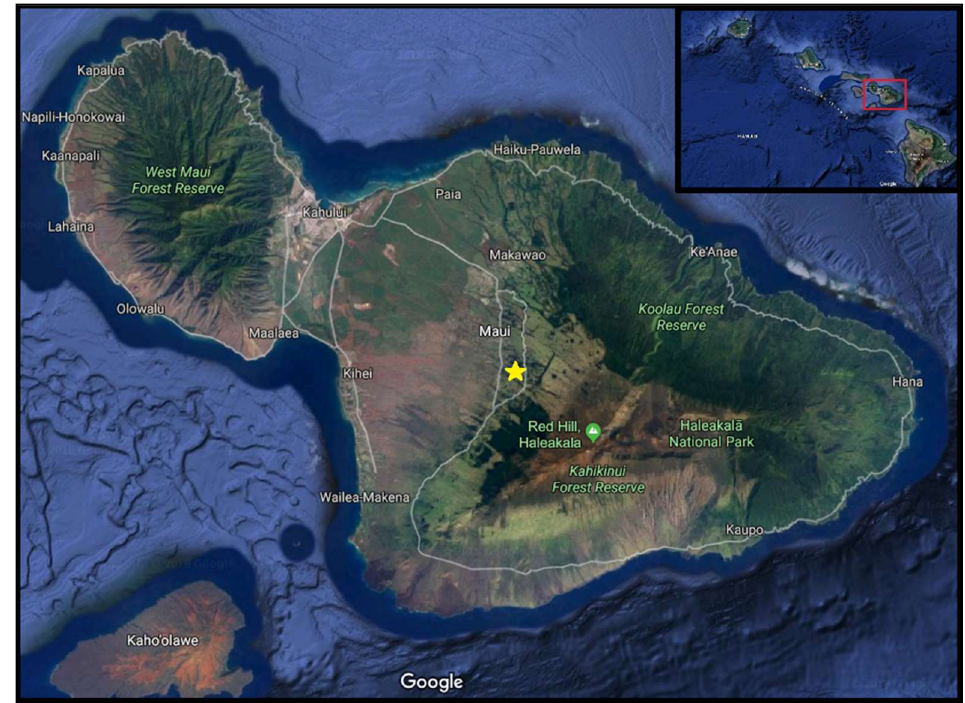
Figure 2. Satellite view of Maui with survey locality designated with yellow star.